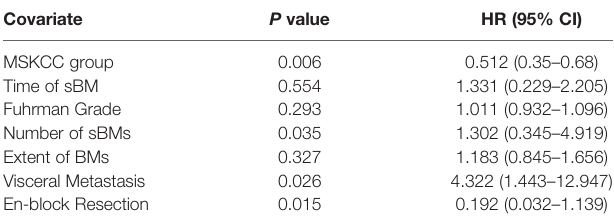
TABLE 2 | COX multivariate analysis for overall survival of RCC with spinal BM. Covariate P